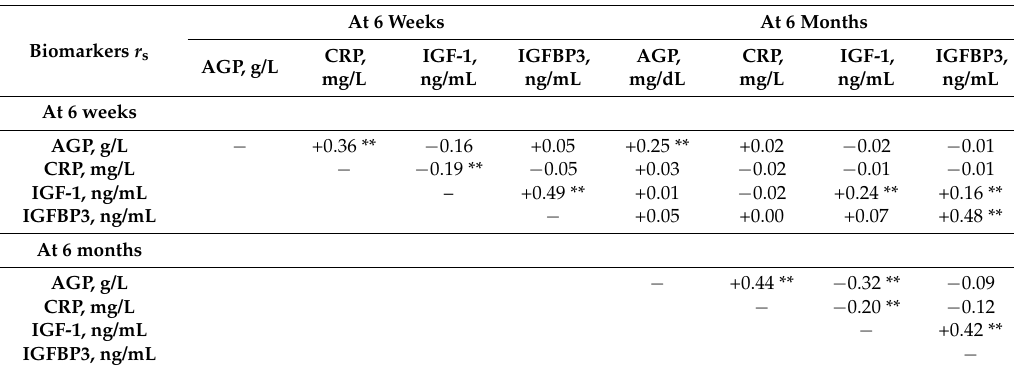
Table 2. Correlation coefficient matrix of inflammatory and growth